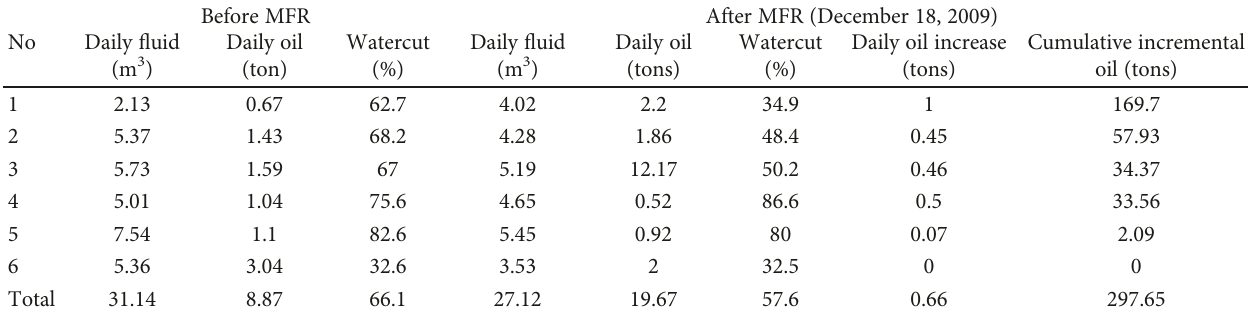
Table 7: Well performance of Ansai MFR pilot [31, 68].